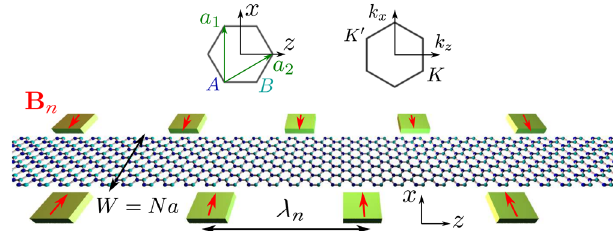
cases.FIG. 1. An armchair GNR formed by a finite strip of graphene aligned along the z axis and of the width W ¼ Na in the x direction. The GNR is composed of two types of atoms, A (blue dot) and B (green dot), and is characterized by hexagons in real and a . The low-energy physics space with translation vectors a 1 2 Þ around the two ; k is determined by the momenta k ¼ ð k x z valleys K ¼ (cid:1) K 0 ¼ ð 4 (cid:2)= 3 a; 0 Þ . Nanomagnets (green slabs) FIG. 2. The spectrum of an armchair GNR obtained by numeri- on the sides of the GNR provide a spatially placed with period (cid:3) n þ (cid:1) H þ caldiagonalizationofthetight-bindingHamiltonian (cid:1) H (red varying magnetic field B 0 SO n (cid:1) H . The low-energy spectrum is linear for metallic [(a),(b) with Z N ¼ 82 ] and quadratic for semiconducting [(c),(d) with N ¼ 81 ] ¼ 1 meV and (d) (cid:3) ¼ 5 meV ] lifts GNRs. The SOI [(b) (cid:3) SO SO the spin degeneracy, so the spectrum consists of (b) two Dirac from zero (shown by cones or (d) two parabolas shifted by k SO green lines). For a metallic GNR, each branch is characterized not only by the spin projection s , but also by the isospin (cid:9) . The solid (dashed) lines correspond to (cid:9) ¼ 1 ( (cid:9) ¼ (cid:1) 1 ) [see (b)]. Whereas ¼ 0 : 1 meV ) for a semiconducting GNR, a magnetic field ( (cid:3) Z (cid:3) 0 : 2 meV [(d)], we also need to include alone opens a gap 2(cid:3) g intervalleyscattering (modeledbyfluctuationsin on-siteenergies) for the metallic GNR [(b)]. If the chemical potential (cid:10) is tuned inside the gap, the system is in the helical regime with nearly i (cid:3) 0 : 99 , in both semiconducting and perfect polarization, h s x metallic degenerate (apart from spin; see below) and gapped by (cid:2) @ (cid:8) = 3 ð M þ 1 Þ a [see Fig. 2(a)]. F